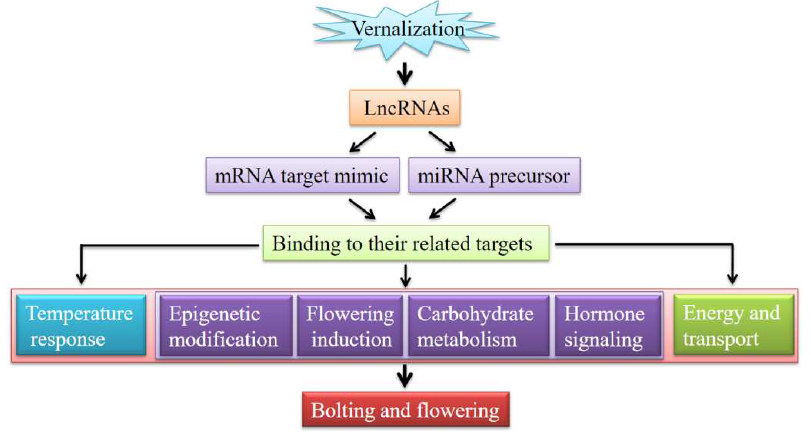
Figure 8. A proposed model of vernalization-induced bolting and flowering by regulatory lncRNAs in A. sinensis .